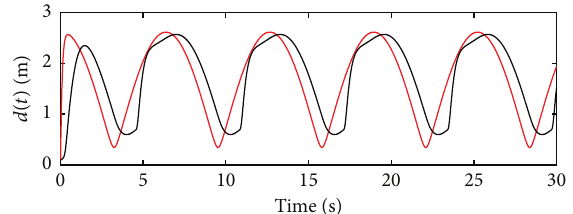
Figure 12: Comparison of following distance with (black) and without (red) saturation.